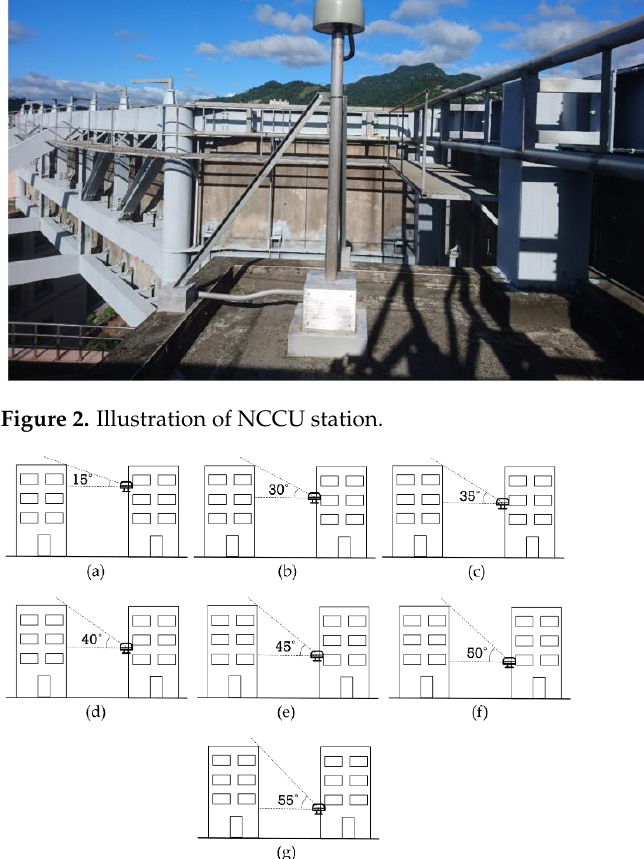
Figure 3. Levels of masking conditions. Subfigures ( a – g ) illustrate the corresponding elevation cutoffs 15 ◦ , 30 ◦ , 35 ◦ , 40 ◦ , 45 ◦ , 50 ◦ and 55 ◦ , respectively.